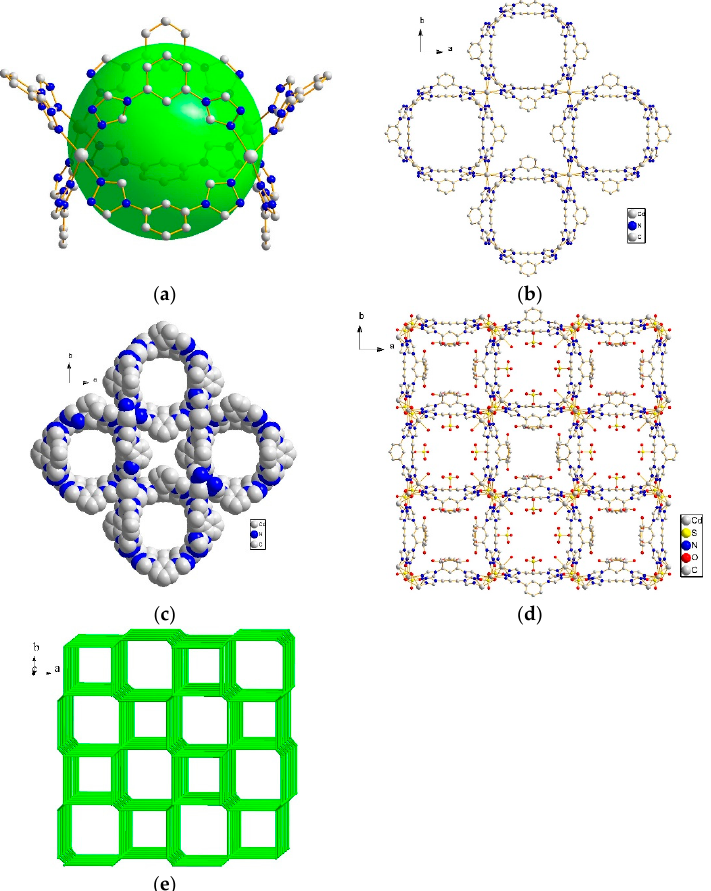
Figure 2. ( a ) The Cd 4 (dtb) 8 secondary building units. ( b ) The three-dimensional framework of compound 1 along the c axis. ( c ) The space-filling representations of the 3D structure showing the 1D channels along the c axis. ( d ) The 3D framework filled by uncoordinated SO 4 2 − anions and phthalic acid molecules. ( e ) The 4-connected net with a point symbol of {4 3 · 8 3